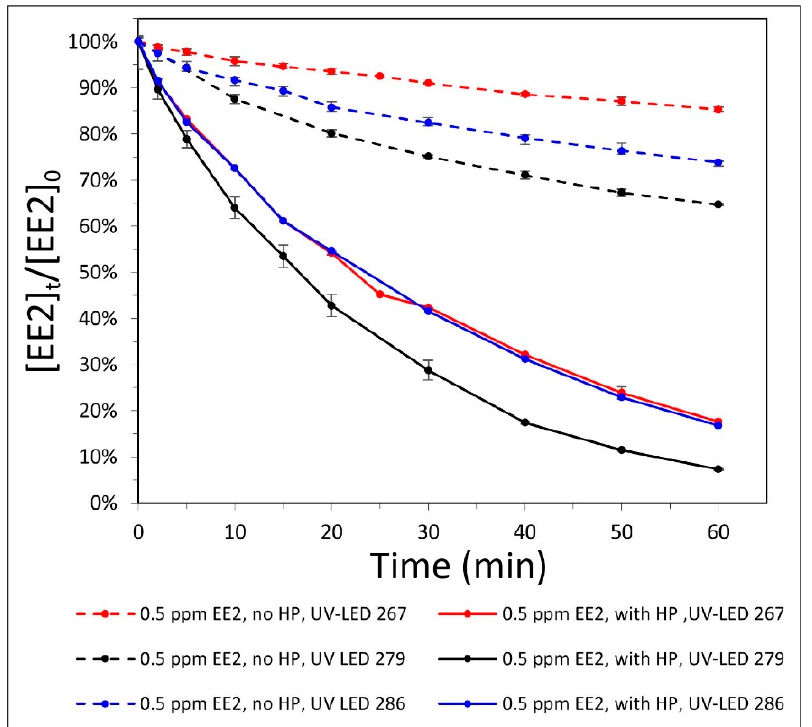
Figure 2. Degradation of 0.5 mg/L EE2 by direct UV-LED or indirect AOP with 10 mg/L H 2 O 2 (HP), using various LED wavelengths, versus time.